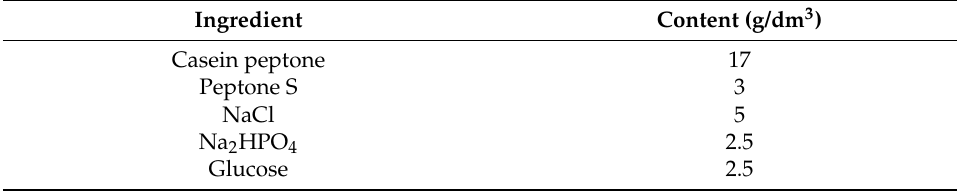
Table 2. Composition of the bacterial medium [65].